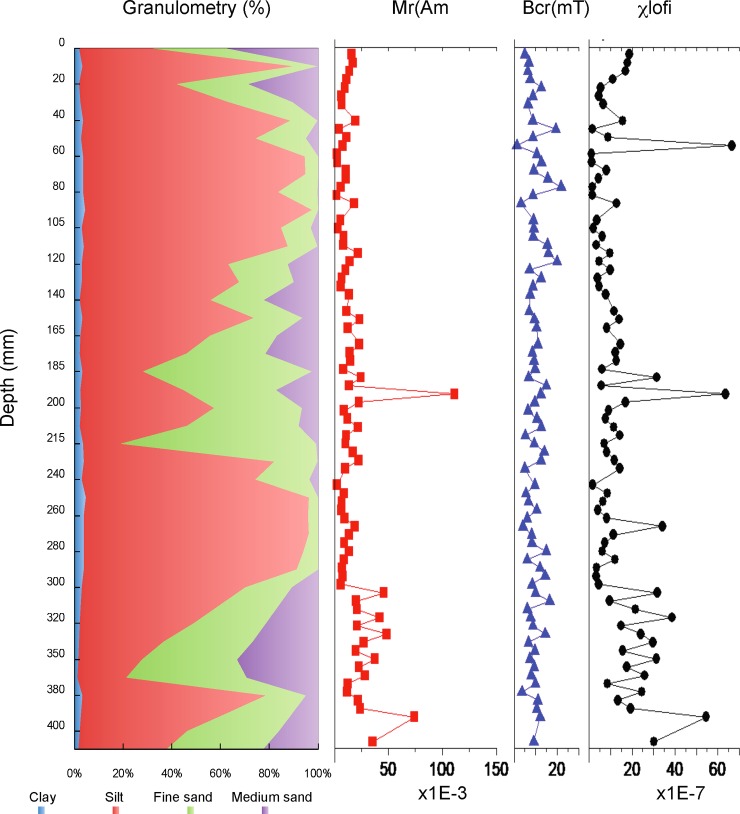
Analysis of CORE1.Grain size, magnetic properties χlofi: low-field susceptibility, χhifi: high-field susceptibility, Ms: saturation magnetization, Mr: remnant magnetization, Hc: coercive force, and Hcr: remnant coercive force).